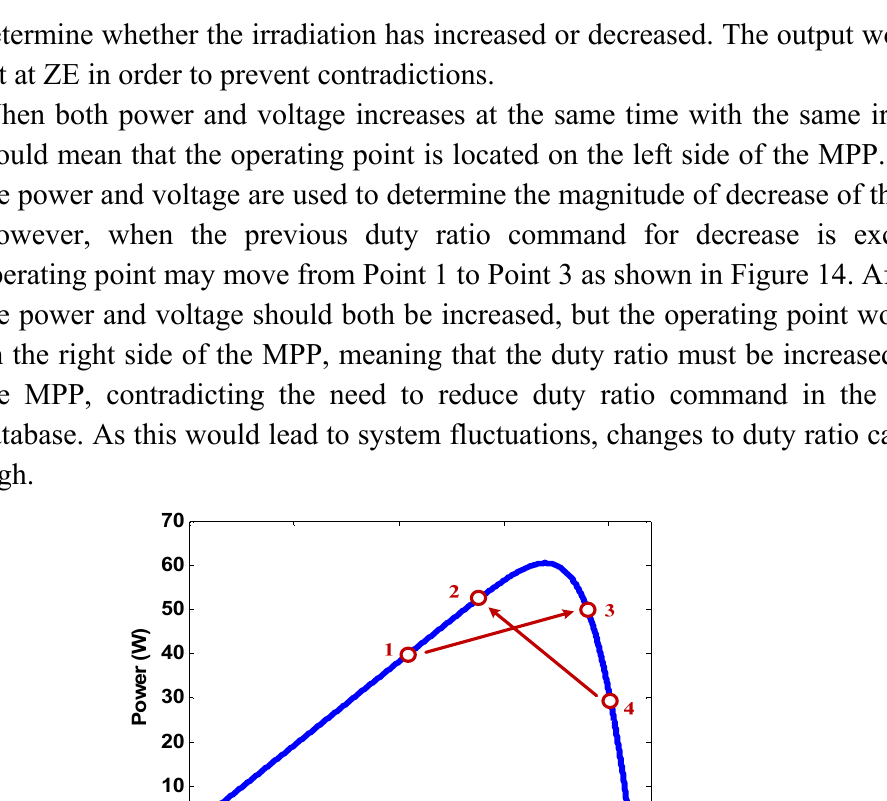
P  and V  as the inputs. PV PV